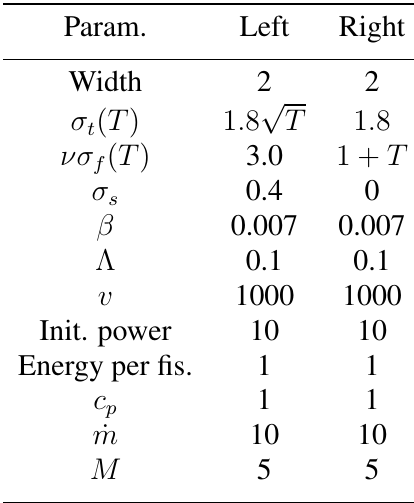
Table I. Model problem parameters